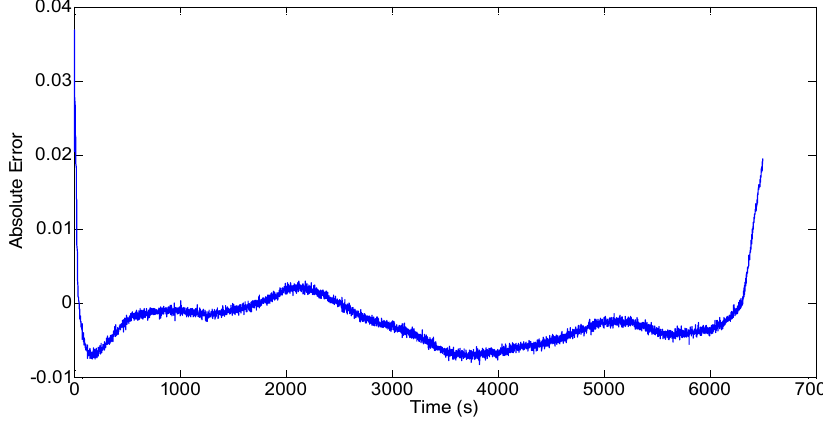
Figure 7. The error of the measured and model terminal voltages.